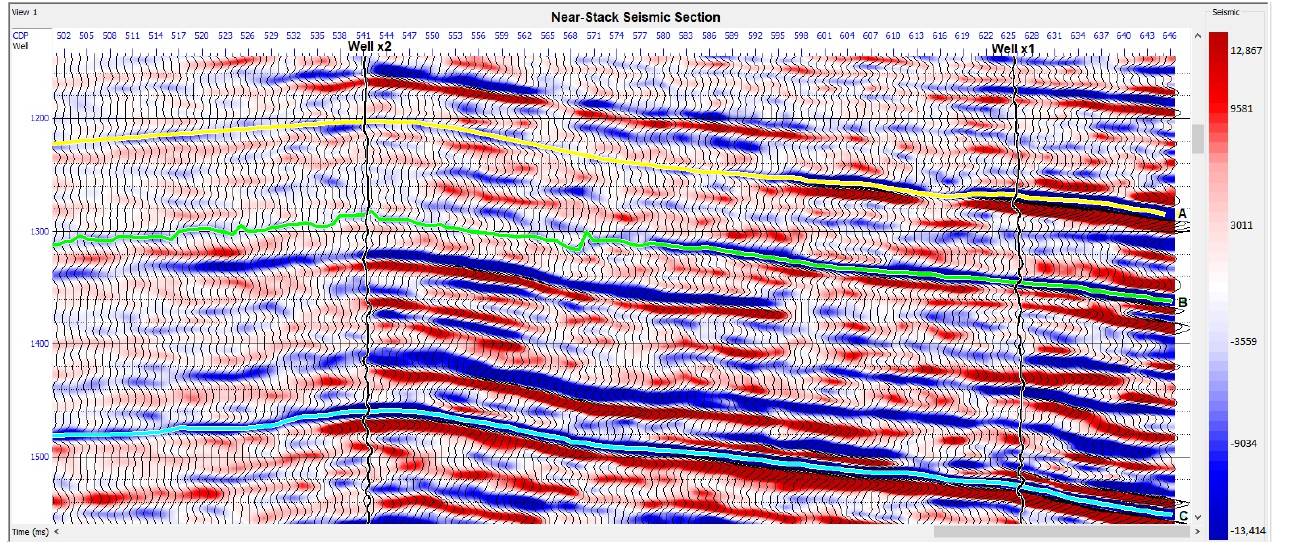
Figure 6. A seismic section extracted from the near-stack volume and tied to the wells × 1, × 2, and × 3, where the horizons’ tops A, B, and C are in yellow, green, and cyan colors, respectively.